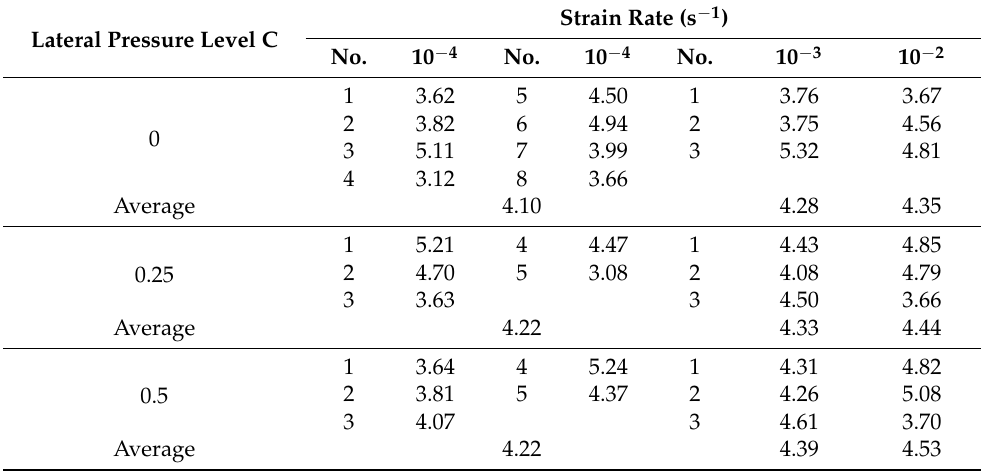
Table 9. ECC deformation modulus under different strain rates and different lateral pressure levels (GPa). Lateral Pressure Level